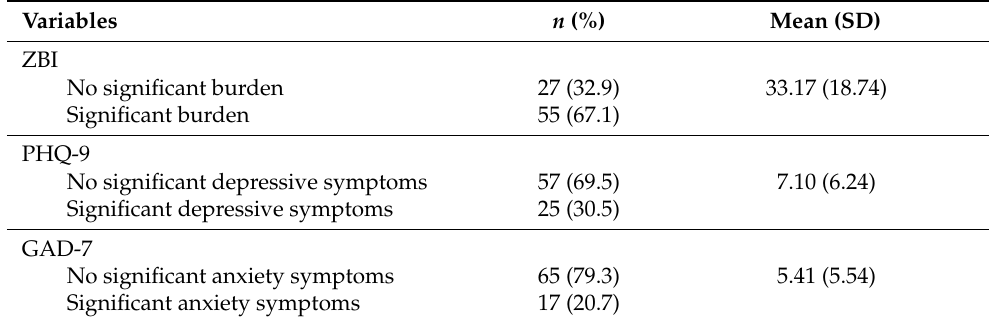
Table 5. Caregiver Burden, Depressive Symptoms and Anxiety Symptoms in Caregivers of